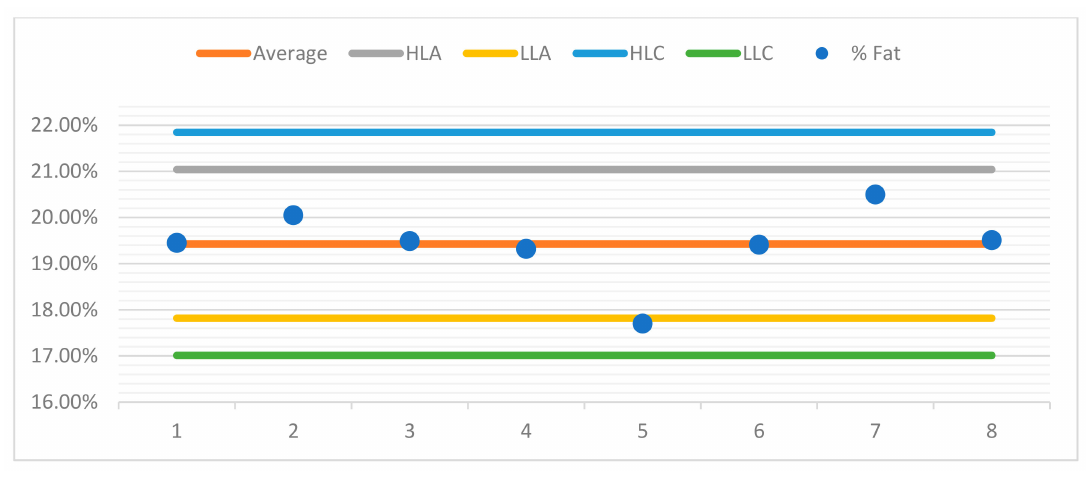
Figure 6. Control chart sample 3.